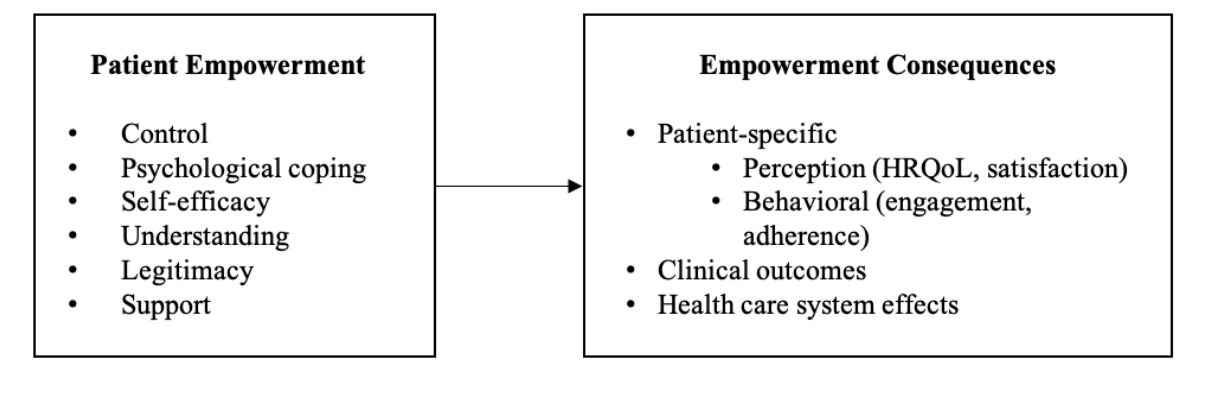
Figure 1. Patient empowerment model (PEM). HRQoL: health-related quality of